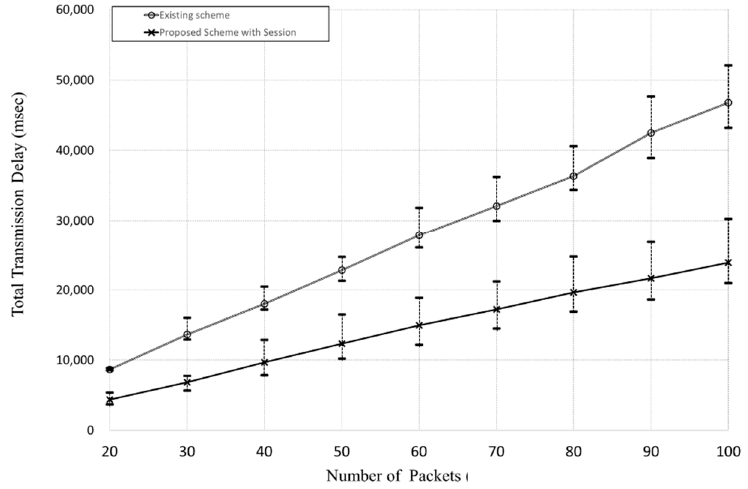
ff erent numbers of